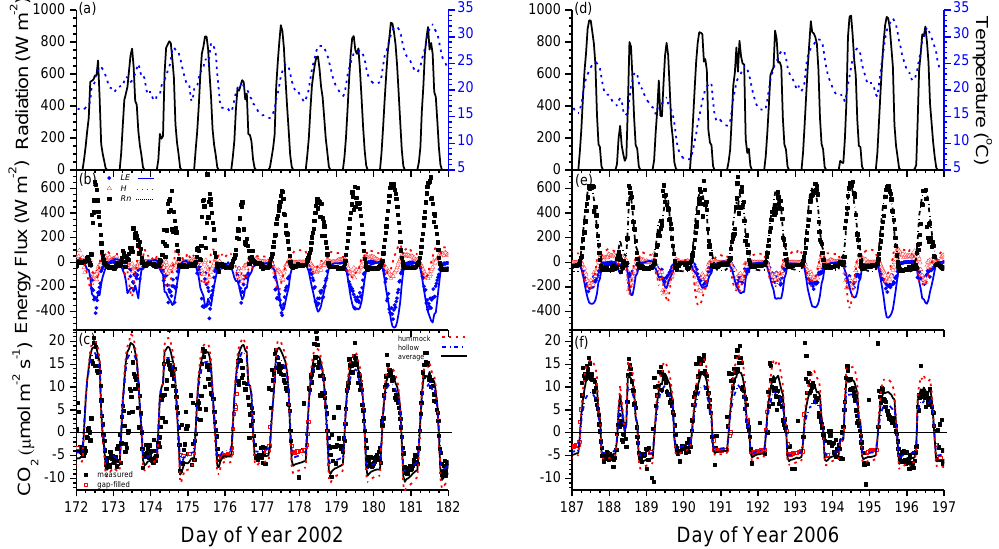
Fig. 5. Radiation and air temperature, energy and CO 2 fluxes measured (symbols) and modelled (lines) during warming events with high water table from DOY 173 to 182 in 2002 (0.2m in Fig. 2) and low water table from DOY 188 to 197 in 2006 (0.7m in Fig. 2). Positive values represent downward fluxes, negative values represent upward fluxes. Table 2. Landscape position, mean annual temperature (MAT), total precipitation, average WTD from hummock surface between DOY 120 and 300 (modelled/measured), foliar N content at anthesis, gross primary productivity (GPP), autotrophic respiration ( R a ) , net primary productivity (NPP), heterotrophic respiration ( R h ), methane emissions (CH 4 ), export of dissolved organic and inorganic C (DOC + DIC), net ecosystem carbon balance (NECB = NEP – CH 4 – DOC – DIC) and net ecosystem productivity (NEP = NPP – R h ) modelled and derived from eddy covariance (EC) measurements for a boreal fen at Lost Creek, WI. Positive values for NECB and NEP represent C gains, negative values C losses. Average values are simple means of those for interconnected hummocks and